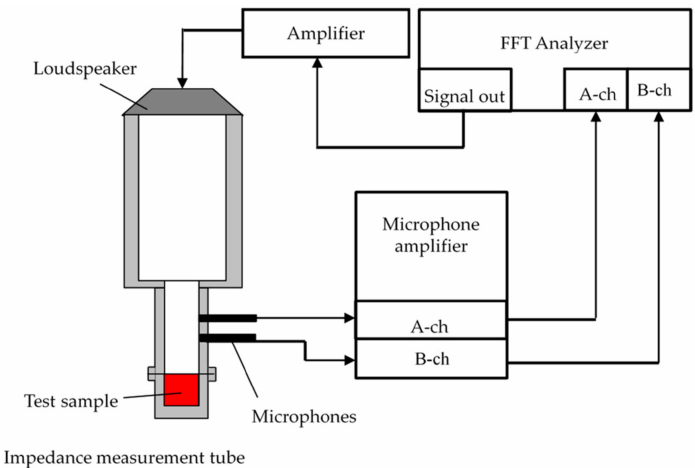
Figure 2. Configuration diagram of a two-microphone impedance tube for the absorption coefficient